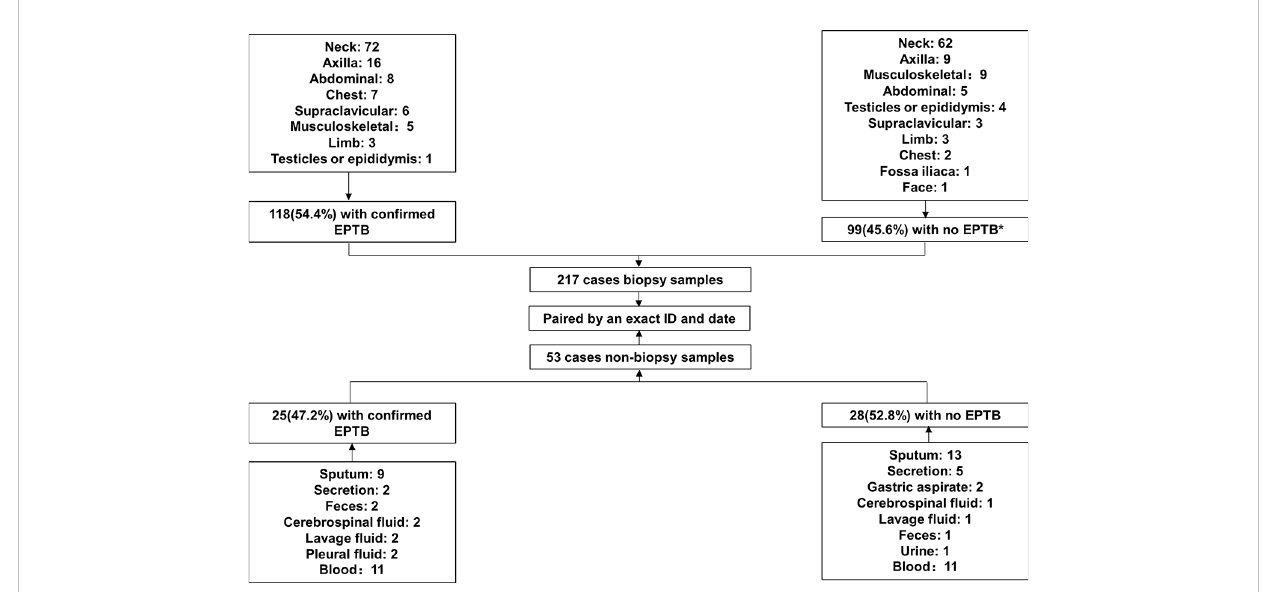
FIGURE 1 Study pro fi le.* 26 cases of lymphadenitis, 2 cases of NTM infection, 3 cases of BCG infection, 8 cases of tumor, 4 cases of Penicillium marneffei infection, 3 cases of Staphylococcus aureus infection, and 53 cases of other non-TB